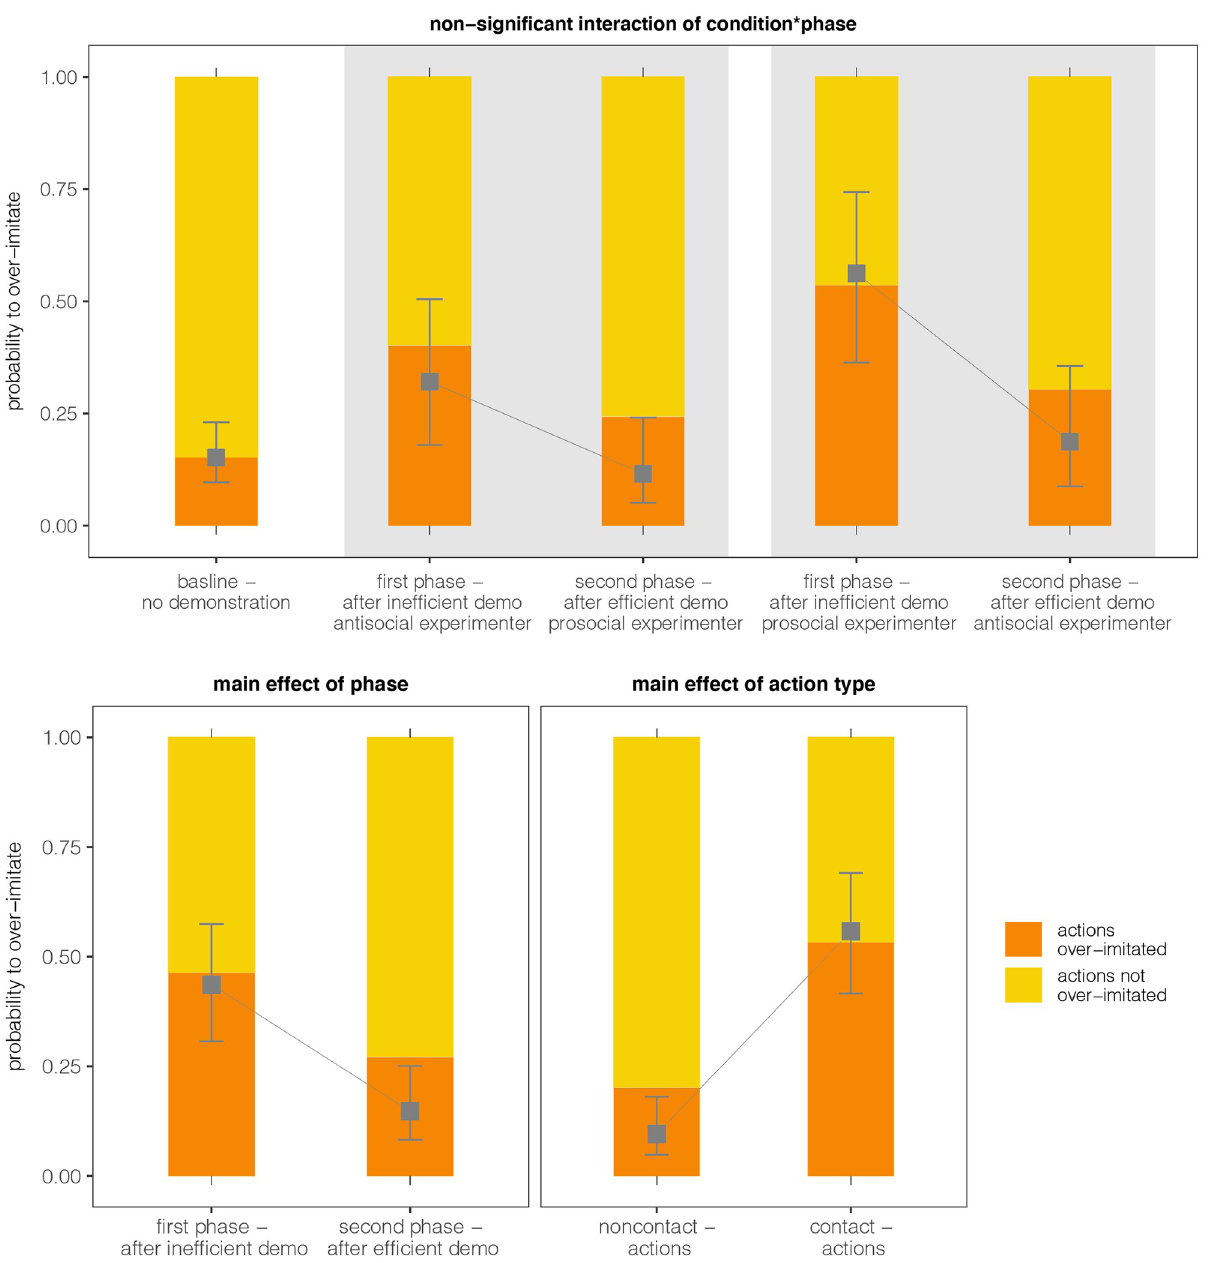
Fig 3. The barplots show the percentages of imitated (orange) and not imitated actions (yellow). The dots represent the point estimates of the GLMM (centered for all other predictors) with the corresponding 95% confidence intervals that were calculated with the package emmeans. Upper figure: Probability of children to over-imitate as a function of condition and test phase. Asterisks depict the results of the post-hoc pairwise comparison ( p -value was mvt adjusted for four tests), and for baseline comparisons ( p -value was Bonferroni adjusted for four tests). Lower left figure: Probability of children to over-imitate as a function of the significant effect of phase. Lower right figure: Probability of children to over-imitate as a function of the significant effect of action type.